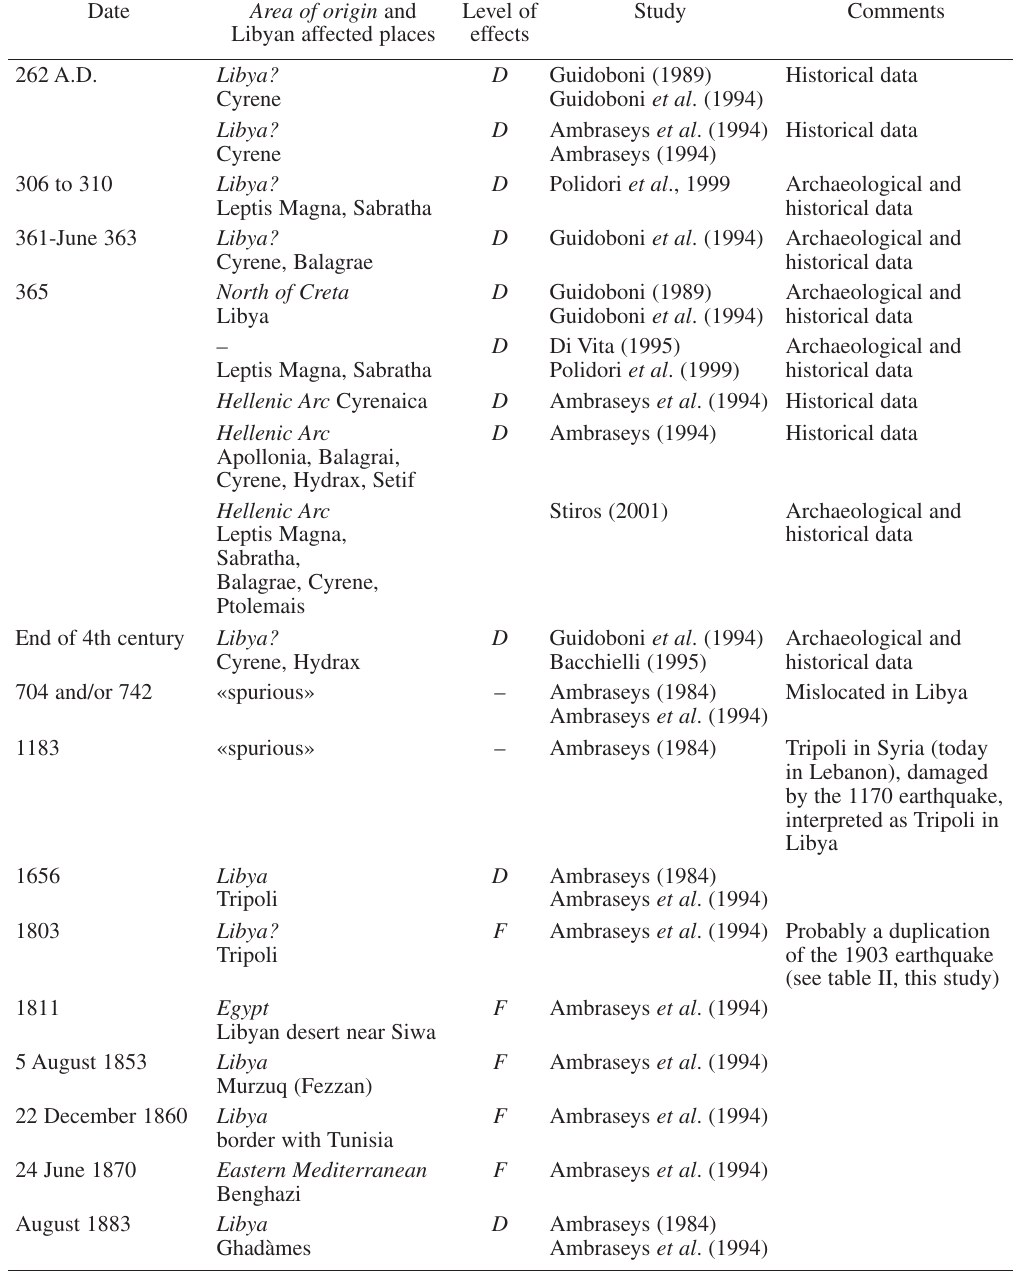
Table I. Earthquake effects in Libya up to 1900 according to the studies published in the last twenty years ( D = damage; F = felt). Date Area of origin and Level of Study Comments Libyan affected places effects 262